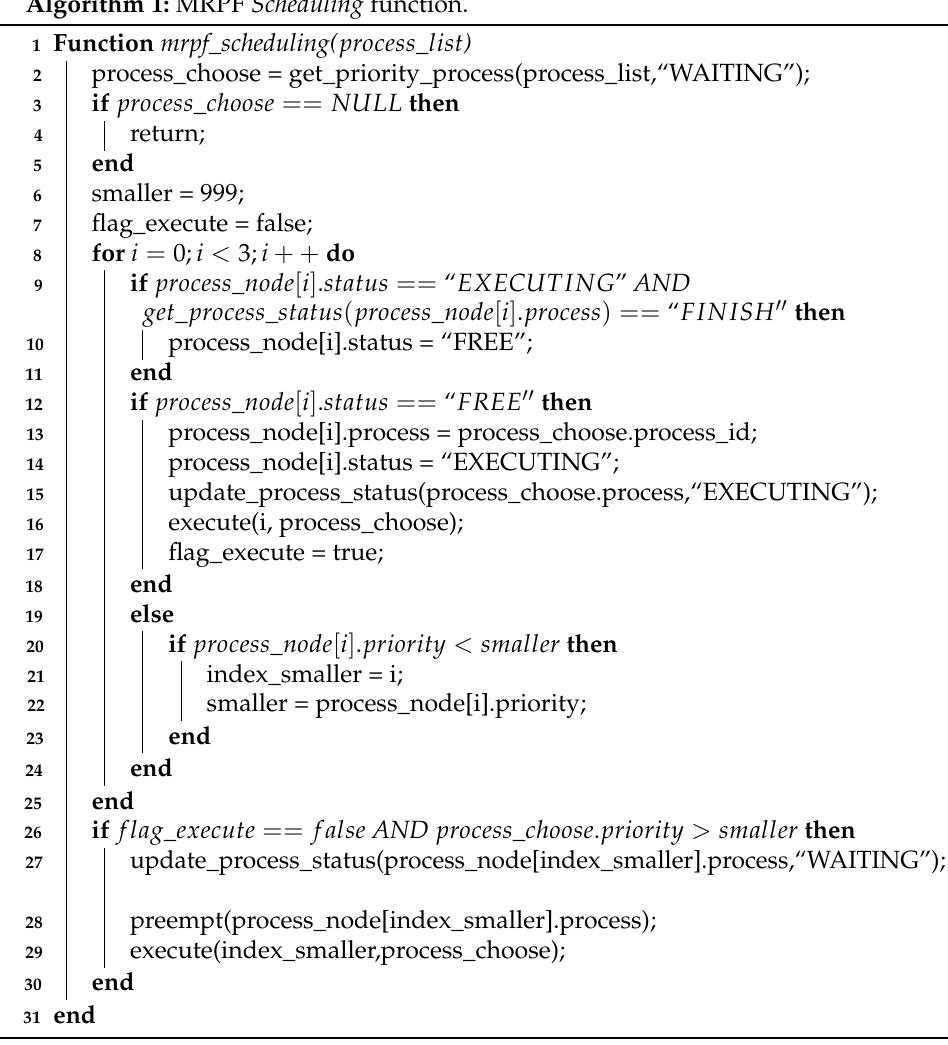
Algorithm 1: MRPF Scheduling